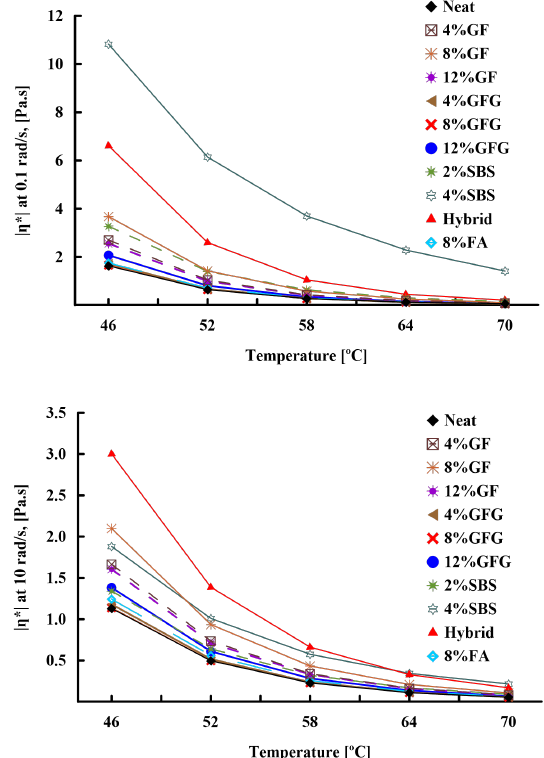
Figure 4. Effects of temperatures and frequencies on the shear